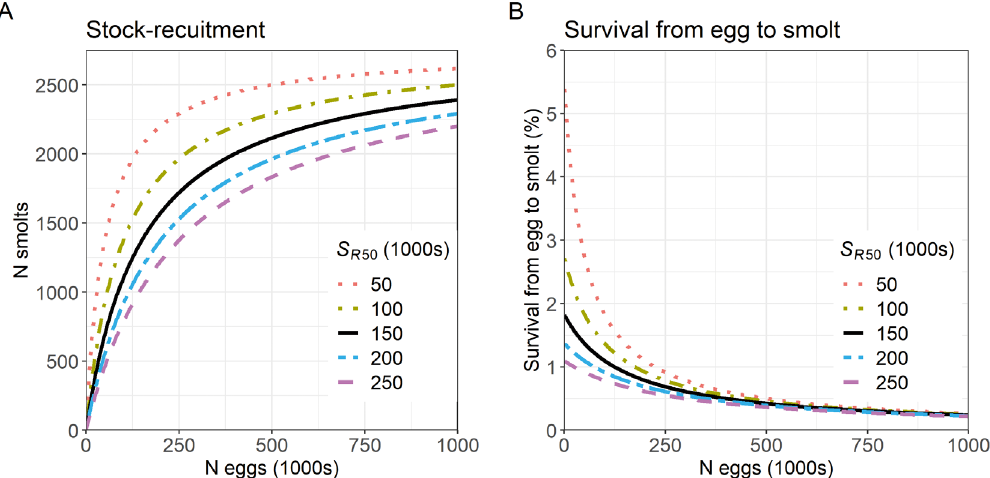
Fig. 2. (A) Stock-recruitment curve and (B) survival from egg to smolt for R max = 2750. Continuous black line: the baseline parameterization of S R50